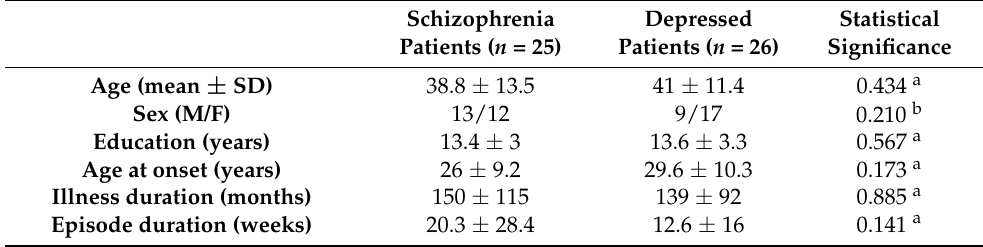
Table 1. Demographic and clinical characteristics of all participants.